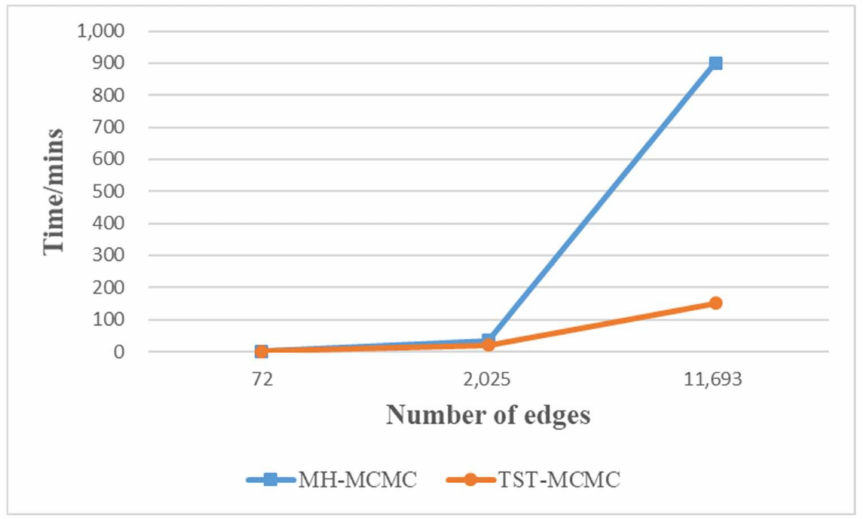
Figure 15. For three networks of different sizes, the time spent at equilibrium between MH-MCMC algorithm and TST-MCMC